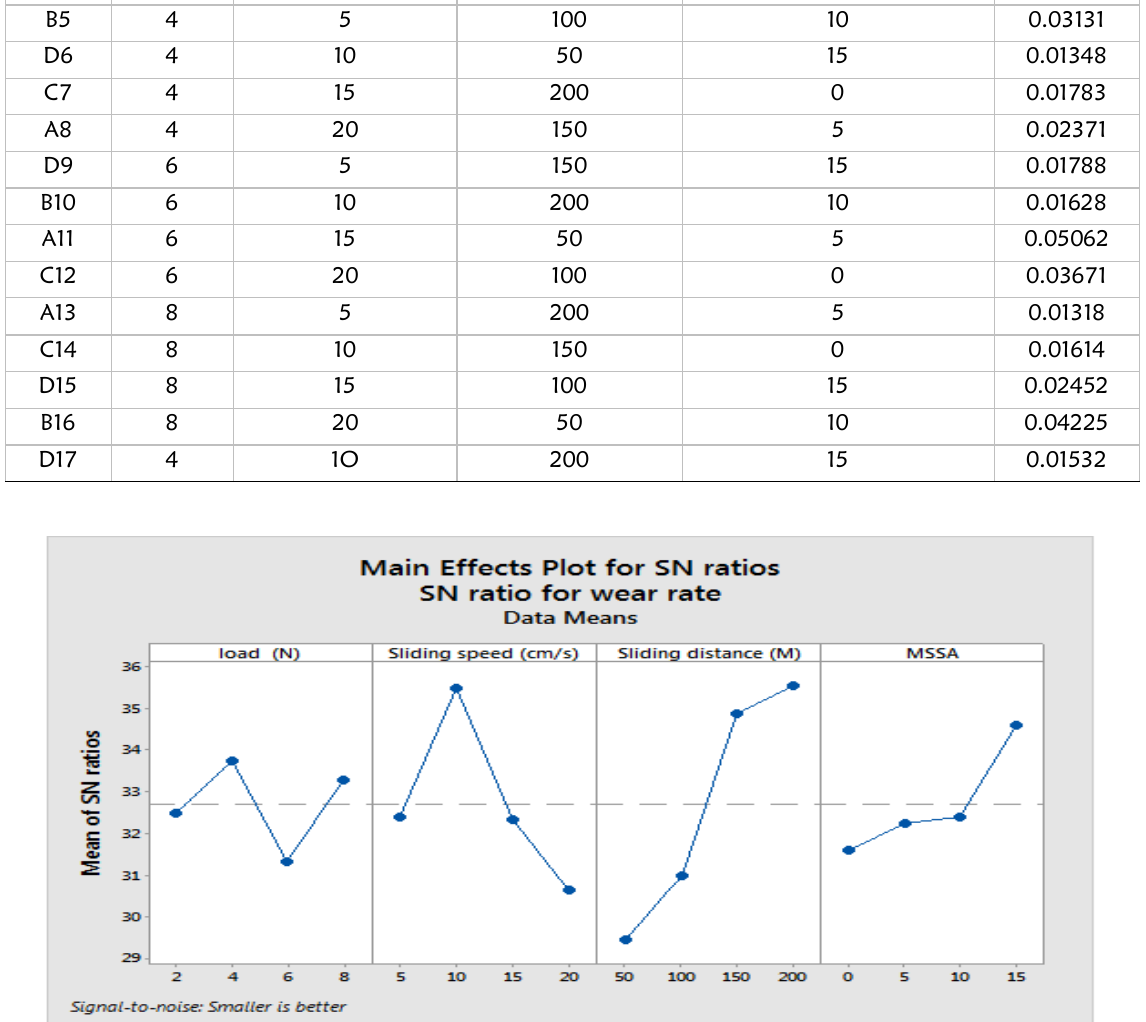
Figure 3: The SN ratio for the data means load, sliding speed, sliding distance and the mango seed shell